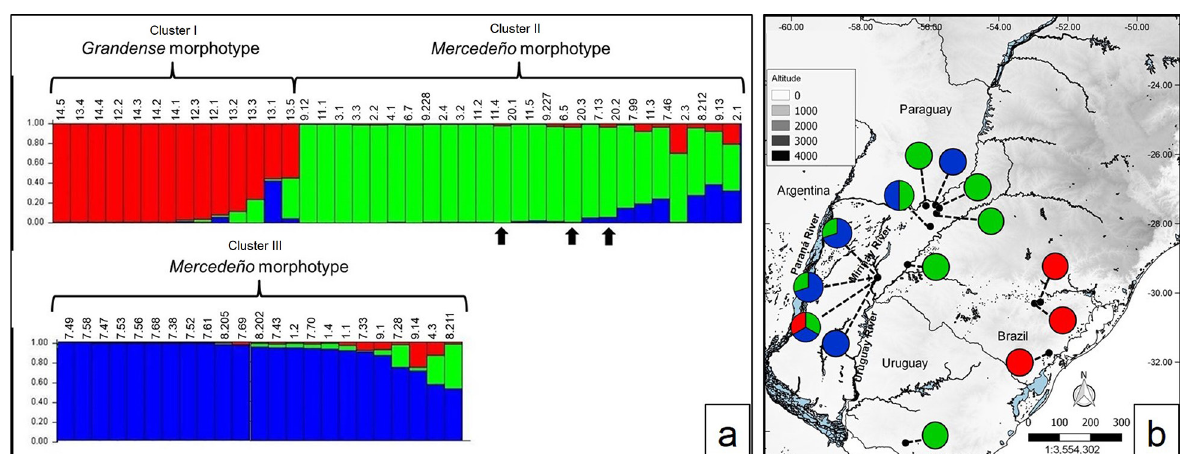
Figure 5. Population structure of Turnera sidoides subsp. carnea inferred by the STRUCTURE software on the basis RAPD markers. a. Each individual is represented by a single vertical bar, which is partitioned into K = 3 colored components that represent each individual’s proportional assignment to one of the genetic clusters. The population ID and the number of each individual analyzed are indicated above its corresponding bar. Arrows mark those individuals of the grandense morphotype which were grouped with mercedeño morphotype. b. Geographic distribution of each genetic cluster inferred in populations